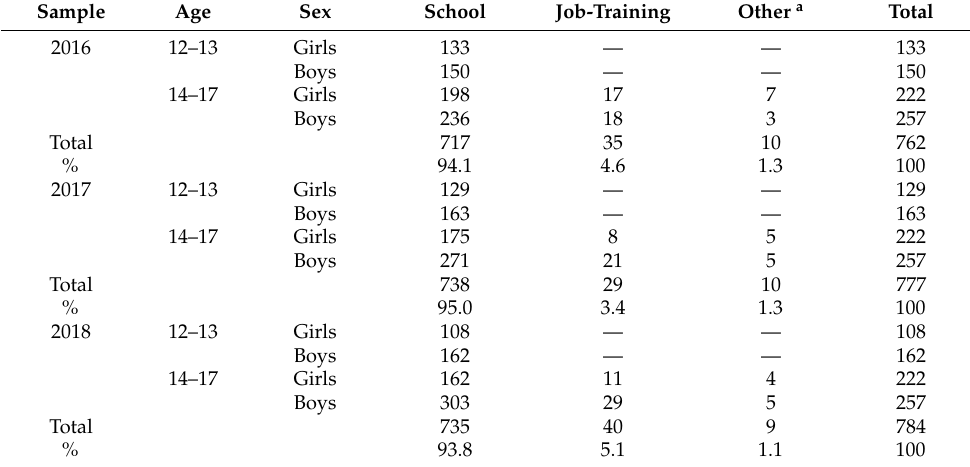
Table 1. Sociodemographic data of the three samples employed in this